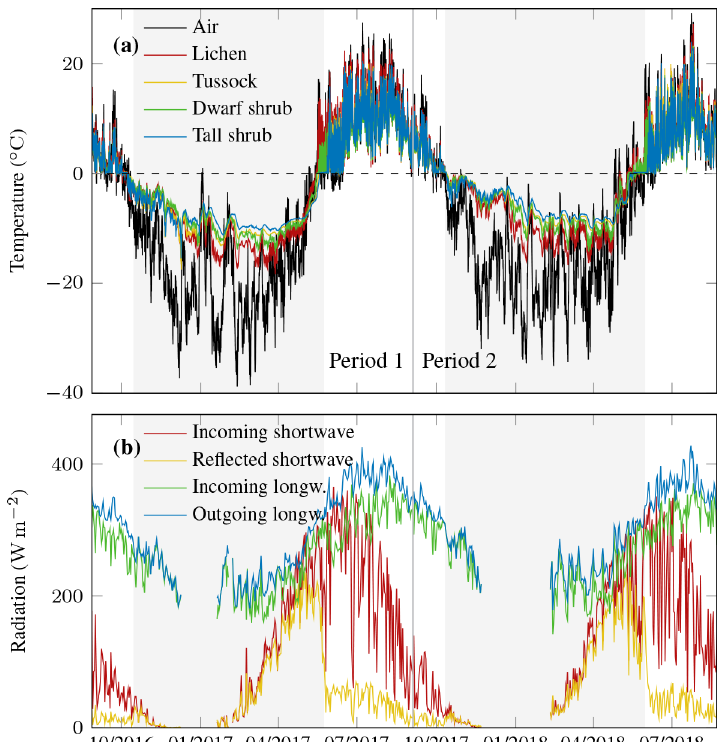
Figure B1. Meteorological conditions at the Trail Valley Creek weather station during the two study periods including snow cover estimated from daily albedo > 0 . 4 indicated as shaded area. (a) Air temperature by Environment and Climate Change Canada (2019) and median topsoil temperature of each vegetation type; (b) daily mean values of four-component radiation.